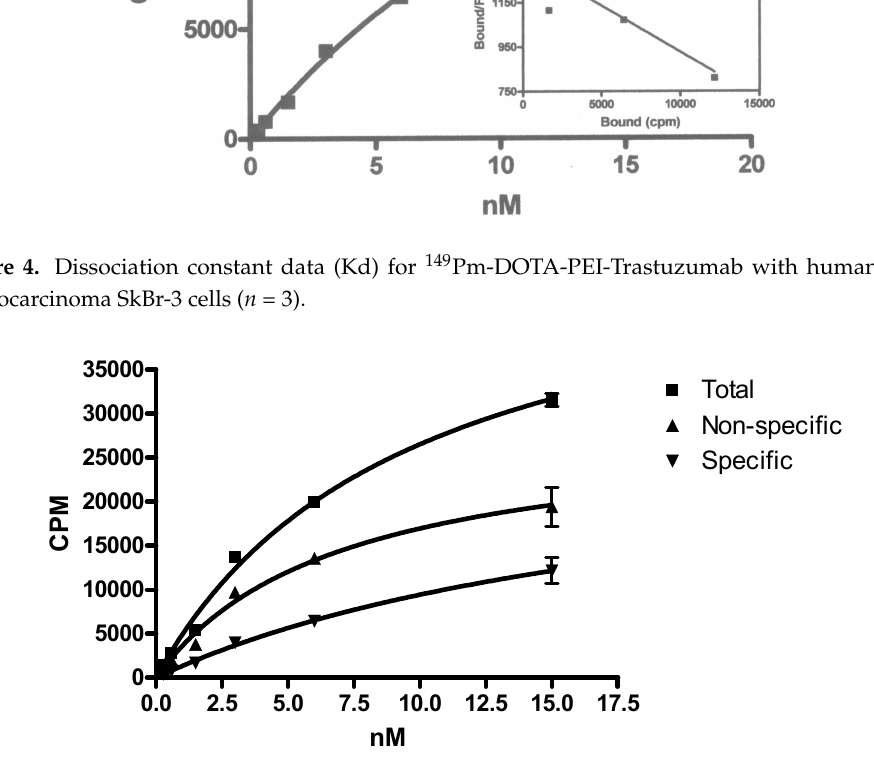
Figure 5. Total, nonspecific and specific binding for 149 Pm-DOTA-PEI-Trastuzumab with human breast adenocarcinoma SkBr-3 cells ( n = 3).